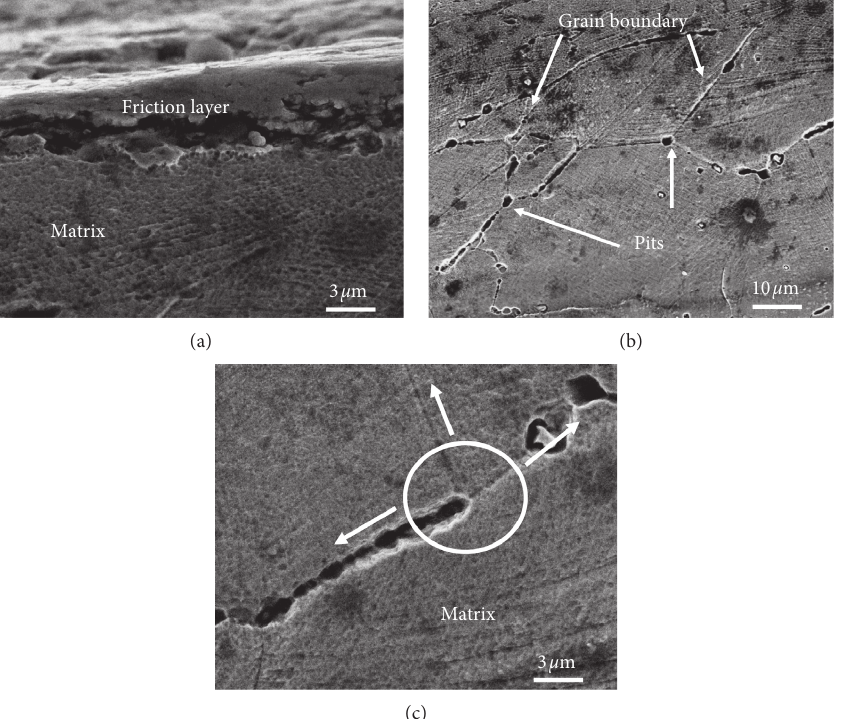
Figure 15: SEM images of the wear surfaces of Inconel 625 superalloy after Si (a); (c, d) EDS of the 1 and 2 regions.